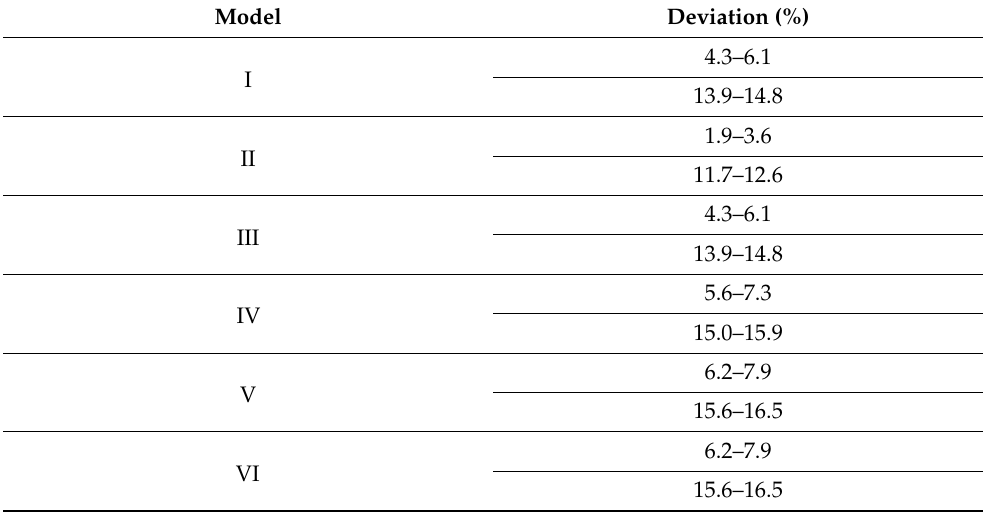
Table 4. Deviation of the eigenfrequencies between the experimental models and